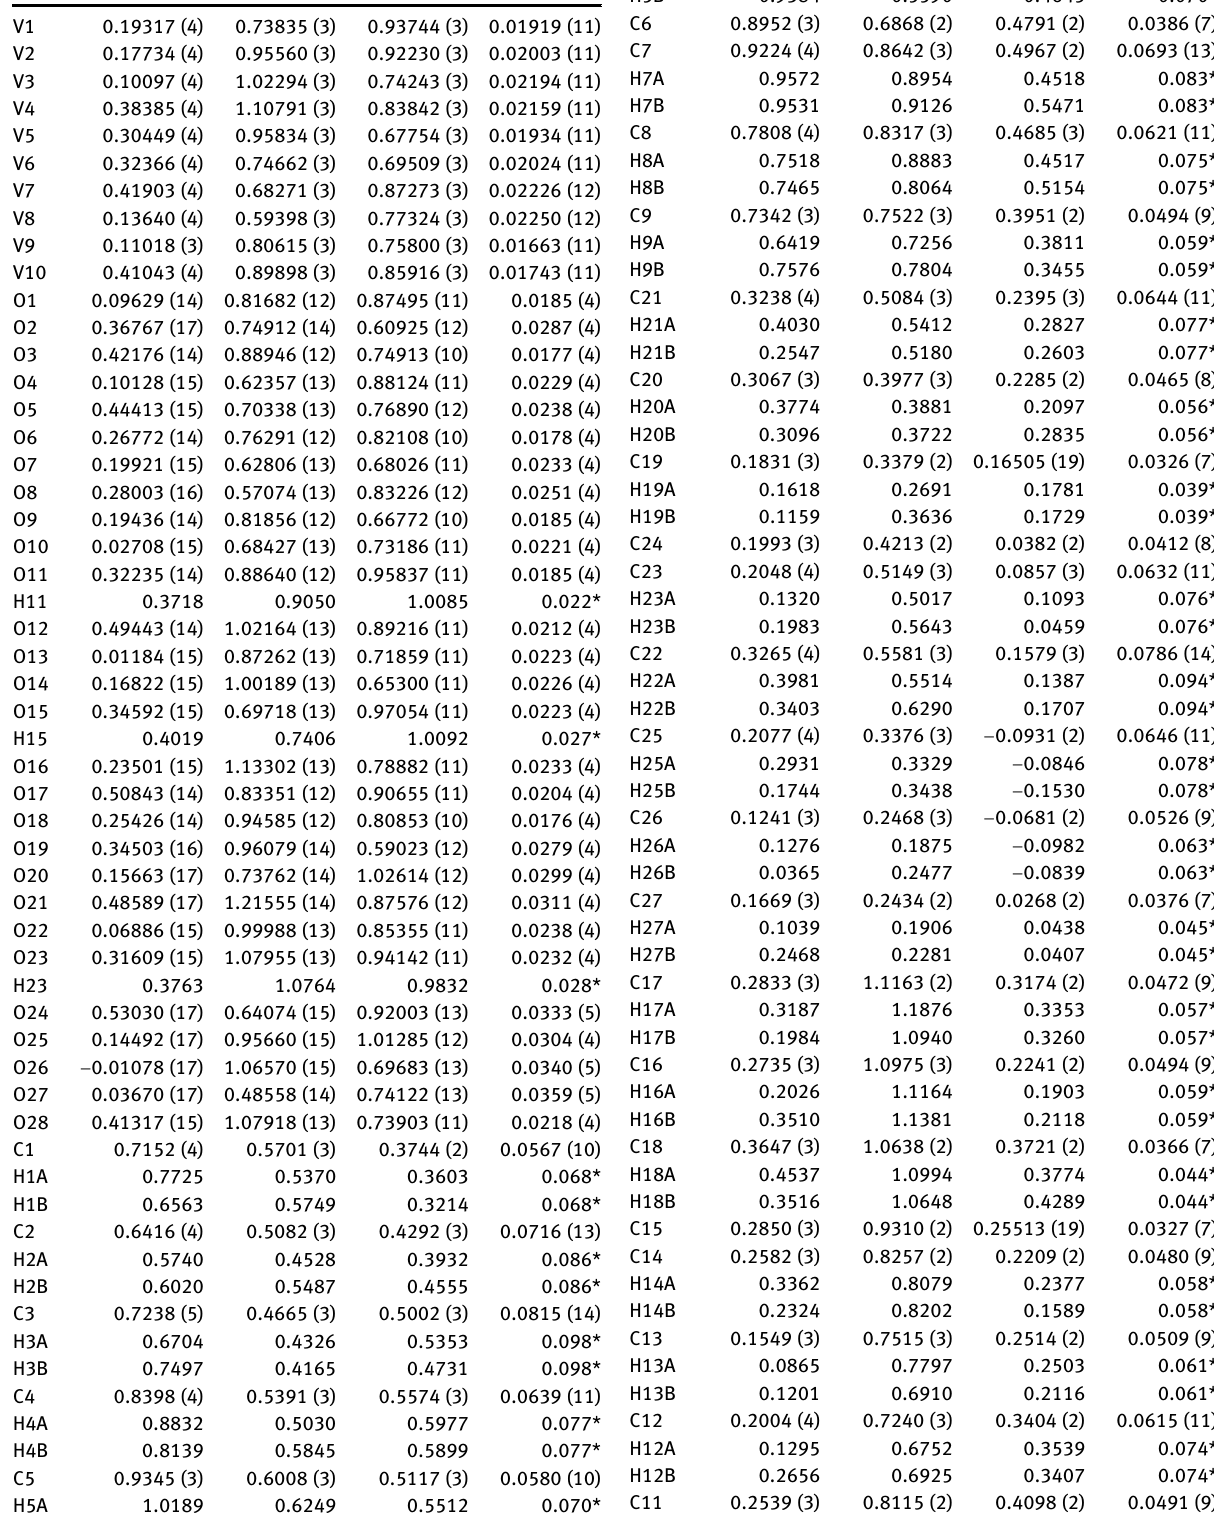
Table  : Fractional atomic coordinates and isotropic or equivalent isotropic displacement parameters (Å 